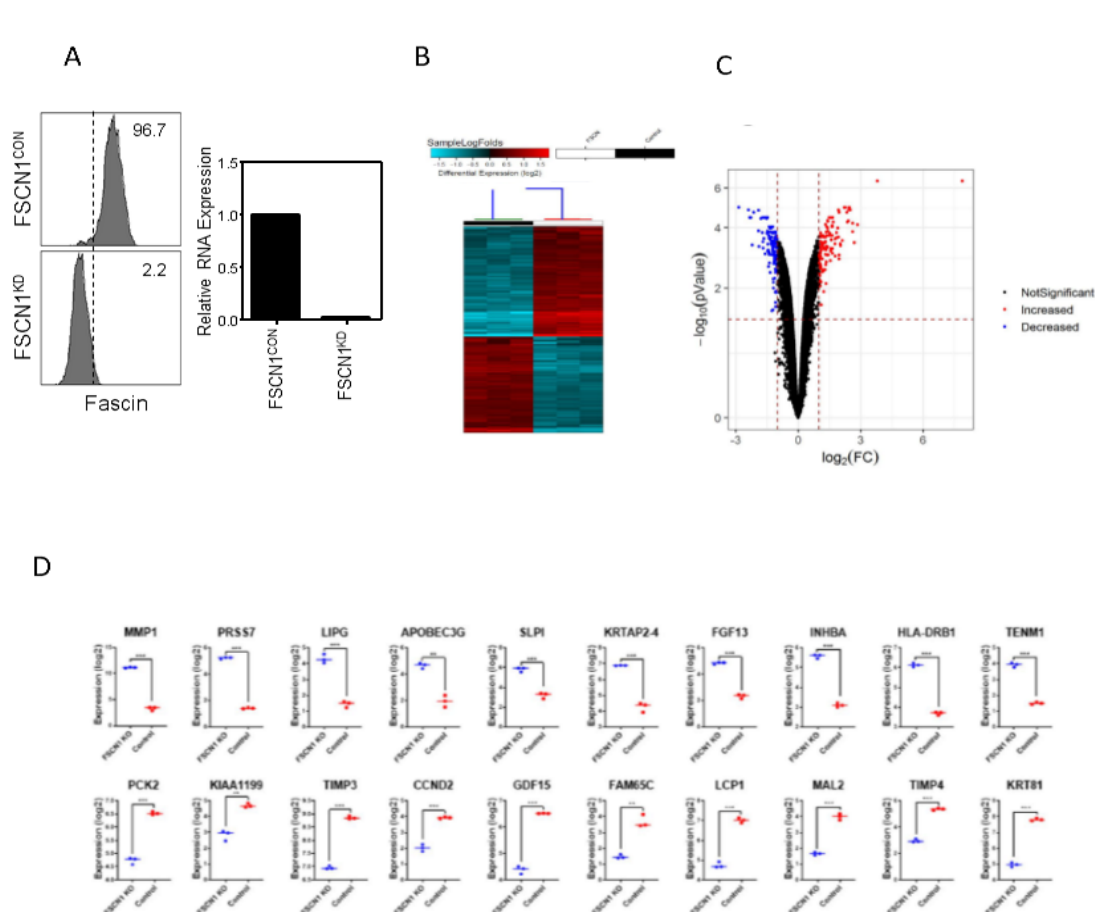
Figure 3. Differential gene expression analysis on FSCN1 KD compared to FSCN1 CON MDA-MB-231 cells. ( A ) Left: FACS histograms showing the levels of fascin expression in FSCN1 CON and FSCN1 KD MDA-MB-231 cells. Right: Bar graph showing the relative RNA expression of fascin in FSCN1 CON and FSCN1 KD MDA-MB-231 cells. ( B ) Heatmap depicting the relative expression levels of differentially expressed genes in FSCN1 KD compared to FSCN1 CON MDA-MB-231 cells. Each column represents one replica, and each row represents a single transcript. The expression level of each transcript in a single sample is depicted according to the color scale. ( C ) Volcano plot representation of significantly altered genes in FSCN1 KD compared to FSCN1 CON MDA-MB-231 cells. Red and blue colors indicate the genes with significantly increased or decreased expression, respectively. Black color indicates no significant change. ( D ) Expression of top 10 upregulated and top 10 downregulated transcripts in FSCN1 KD compared to FSCN1 CON MDA-MB-231 cells based on microarray data ( n = 3). ** p < 0.005, *** p < 0.0005.